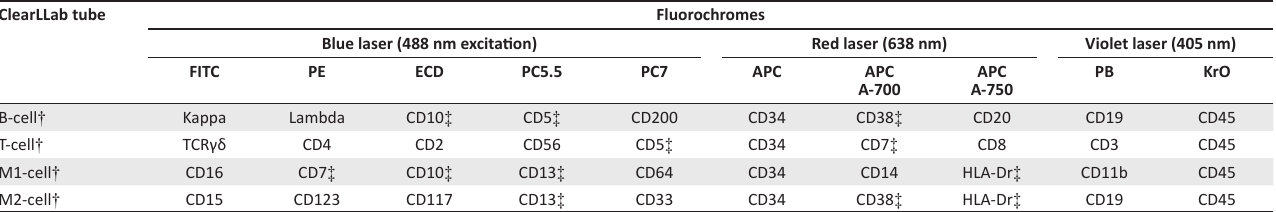
TABLE 2: Reagents used with the ClearLLab 10C panels verified at the Charlotte Maxeke Johannesburg Academic Laboratory in Johannesburg, South Africa, August 2019 – November 2019. ClearLLab